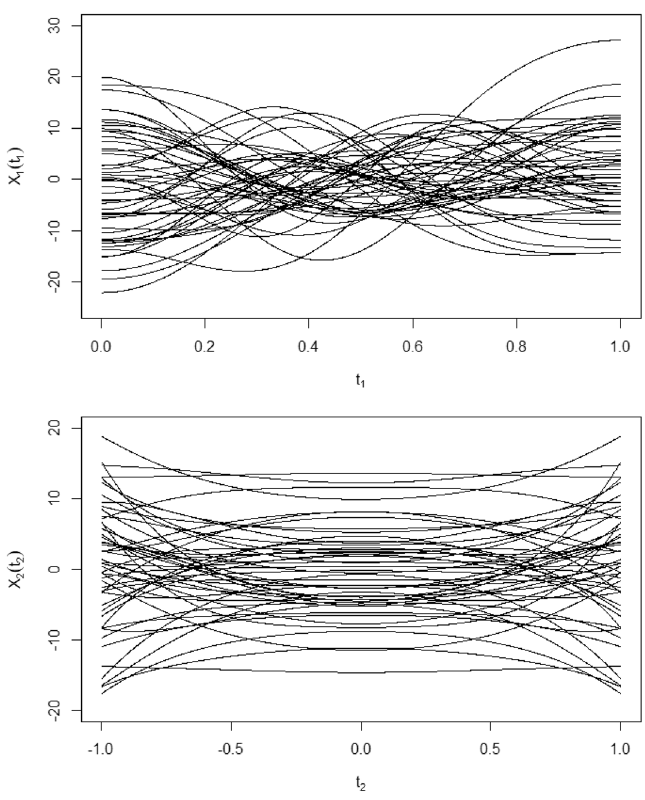
Figure 1. Part of the X 1 ( t 1 ) and X 2 ( t 2 ) .